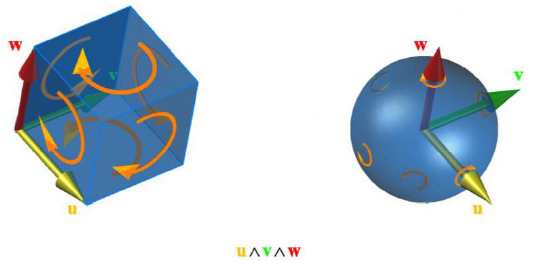
Figure 16: The geometric interpretation of the exterior product of three vectors u , v , w as an oriented volume. Two possible shapes are shown: a parallelepiped and a sphere. The actual shape is irrel- evant to the exterior product.